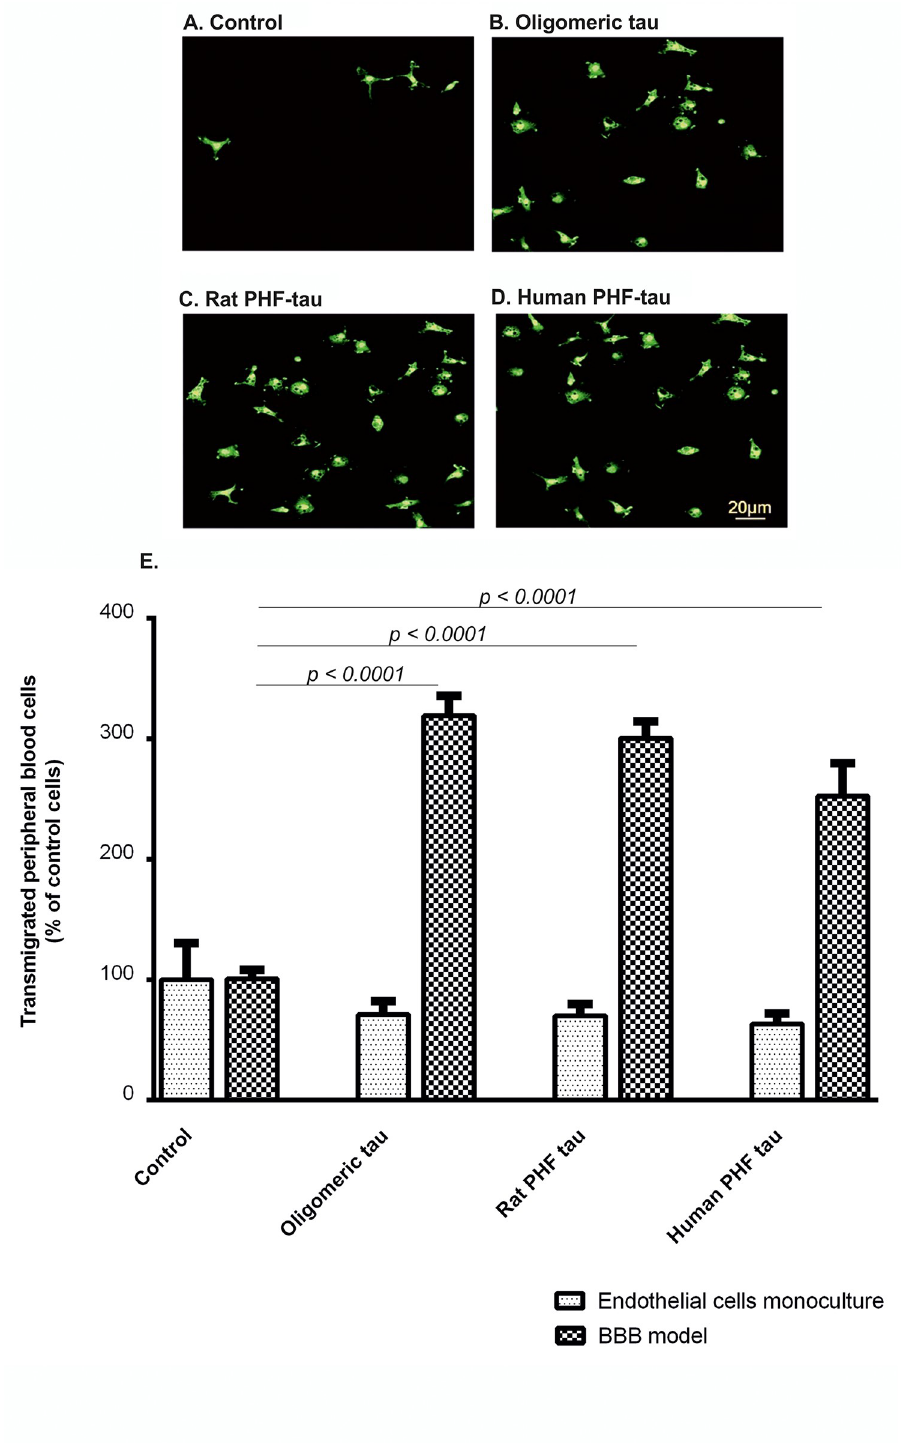
Fig 9. Oligomeric tau and PHF-tau stimulate PB-MoM transmigration across the in vitro BBB model. Effect of the interaction of oligomeric tau and PHF-tau with rat primary mixed glial cells on the transmigration of peripheral blood cells across in vitro BBB model. (A) After 24 hours, CD45 positive transmigrated peripheral blood cells were stained and examined by immunocytochemistry in control conditions, (B) after stimulation with oligomeric tau, (C) rat PHF- tau and (D) human PHF-tau and (E) quantified. Scale bar 20 μ m. Data are means ± SD of individual experiments run in sixplicate, n = 30. Differences at p < 0.05 were accepted as statistically significant. https://doi.org/10.1371/journal.pone.0217216.g009 PLOS ONE | https://doi.org/10.1371/journal.pone.0217216 May 23,